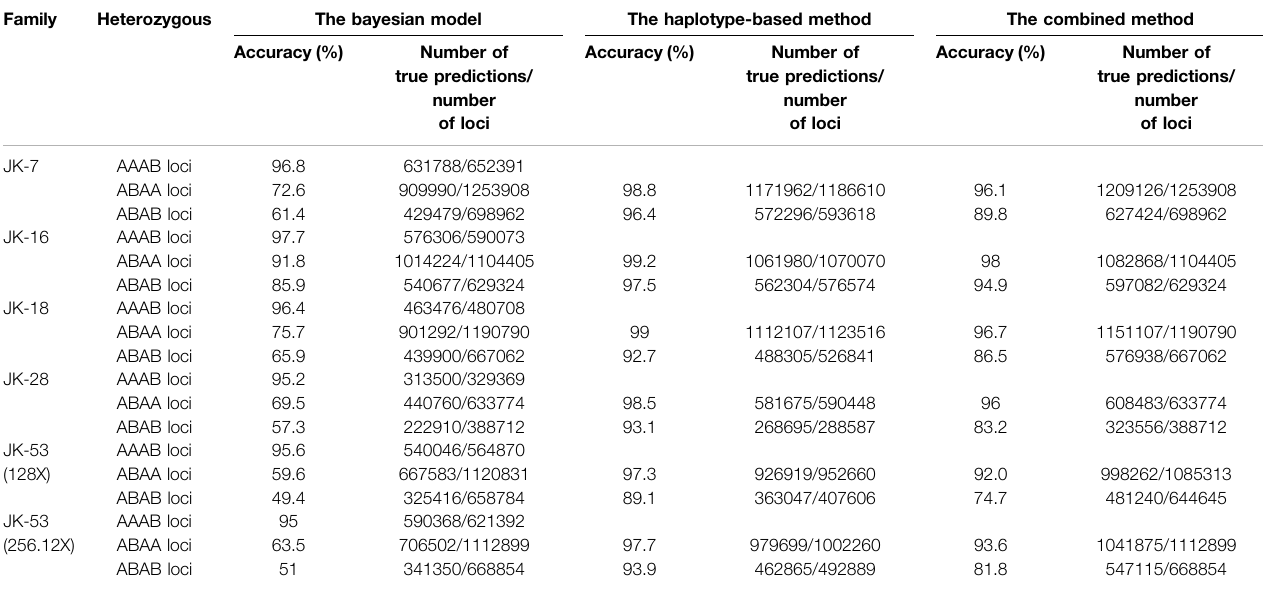
TABLE 1 | Performance metrics for inferring fetal SNPs in 5 healthy